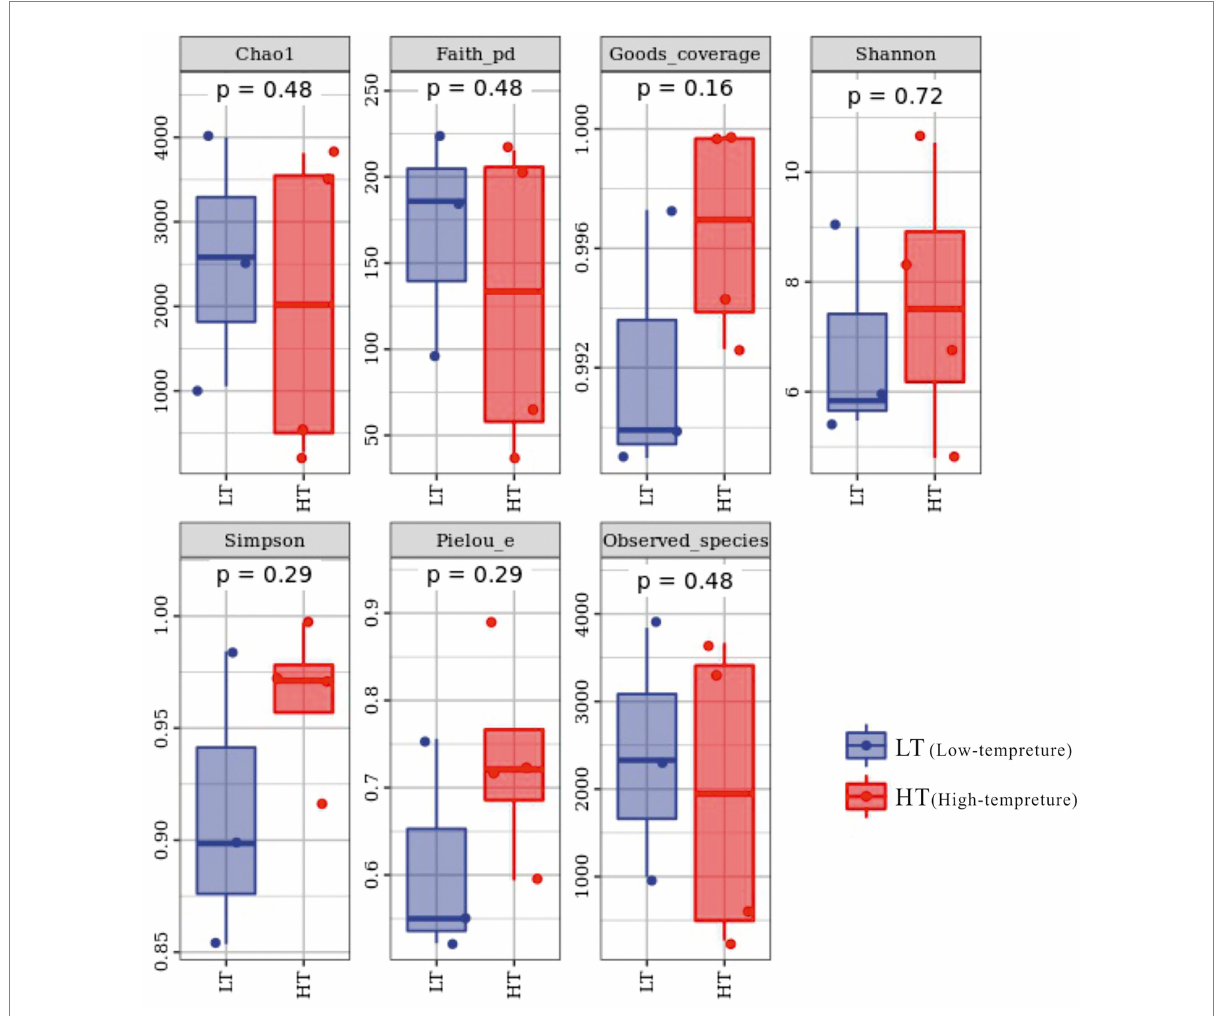
FIGURE 2 Box chart of Alpha index of groundwater bacterial